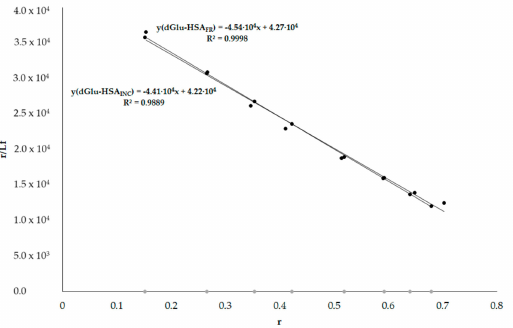
Figure 6. Scatchard curve for dGlu–HSA FR and dGlu–HSA INC systems; λ ex 350